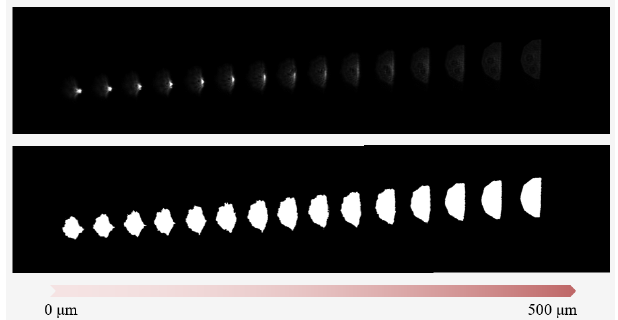
Figure 12. Experimental original and processed laser spot images on CCD 1 with different defocus distances, respectively. The top one is original and the bottom one is processed.